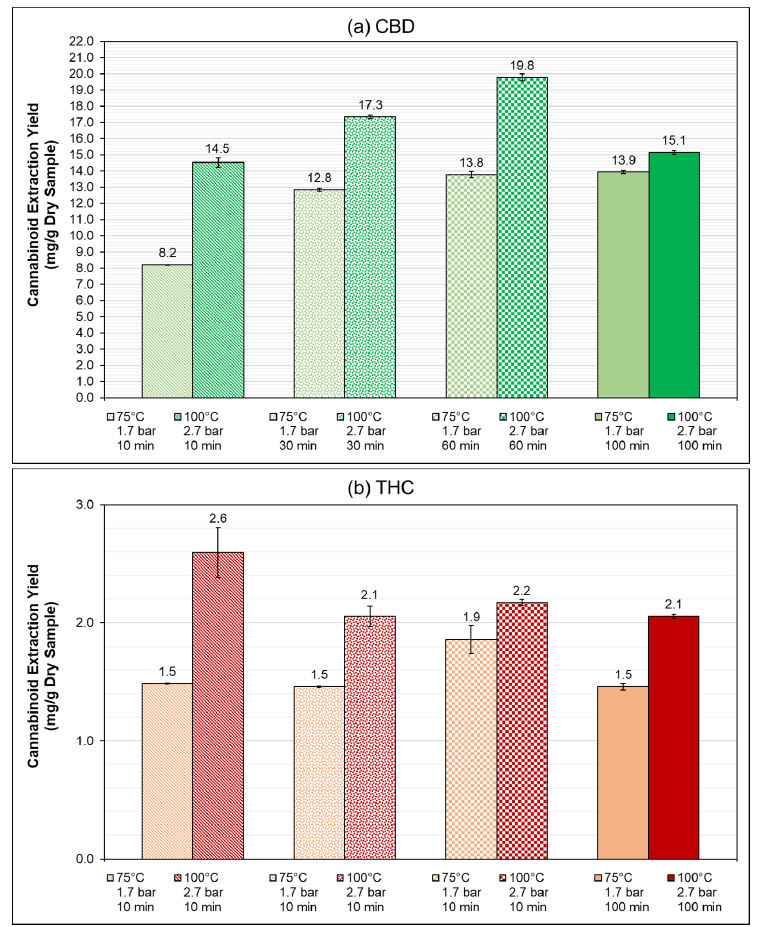
Figure 4. Cannabinoid extraction yield of the PLE experiments performed in the 1 L autoclave with hemp variety Finola (Section 2.5, Table 1). ( a ) CBD, and ( b ) THC. Average value of the duplicates. ANOVA analysis: p -values were 0.01 and 0.24 for CBD and THC, respectively.